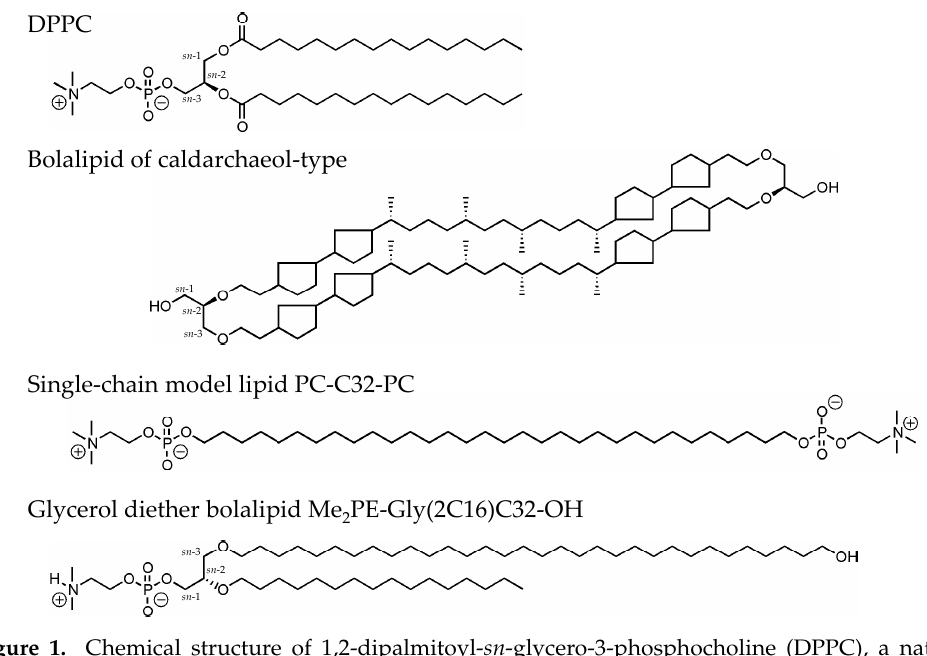
Figure 1. Chemical structure of 1,2-dipalmitoyl- sn -glycero-3-phosphocholine (DPPC), a natural occurring bolalipid of the caldarchaeol-type, the single-chain model lipid PC-C32-PC , and the new glycerol diether bolalipid Me 2 PE-Gly(2C16)C32-OH investigated in this work.